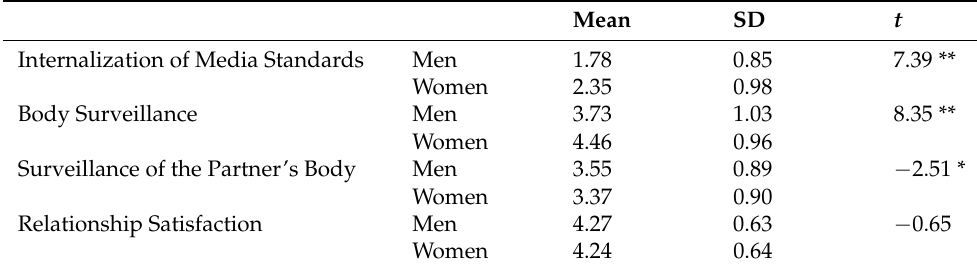
Table 2. Sex differences on the study variables: means, standard deviations, and Student’s t -Test scores. Mean SD t Internalization of Media Standards